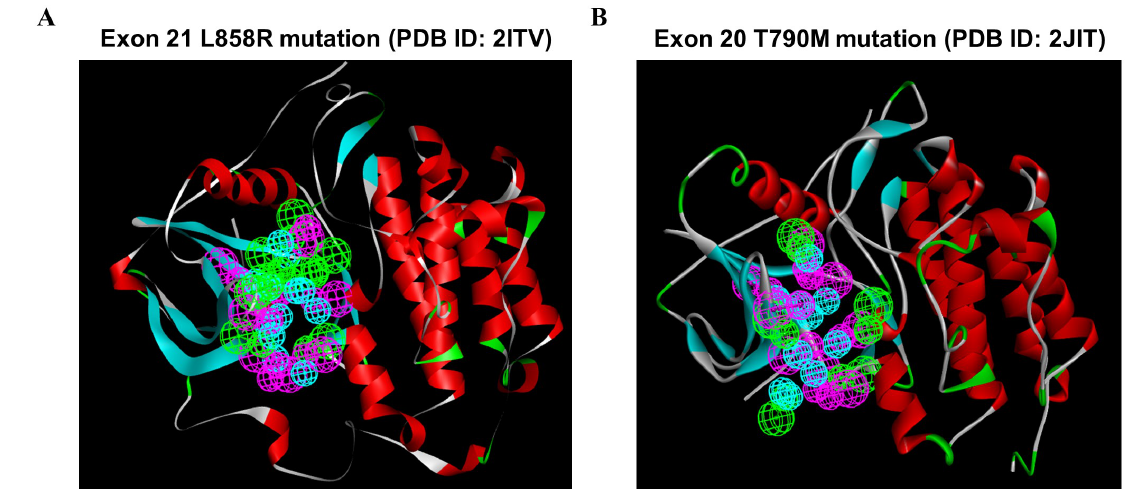
Figure 4. The structure-based pharmacophoric features involving the ATP-bound pocket of the EGFR L858R and T790M structures. Pharmacophore features were identified on the basis of the